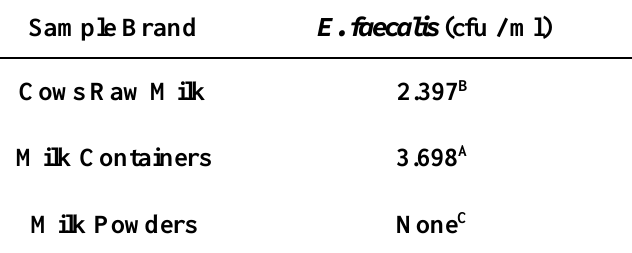
Table 3 . Mean log count of E. faecalis (cfu/ ml)